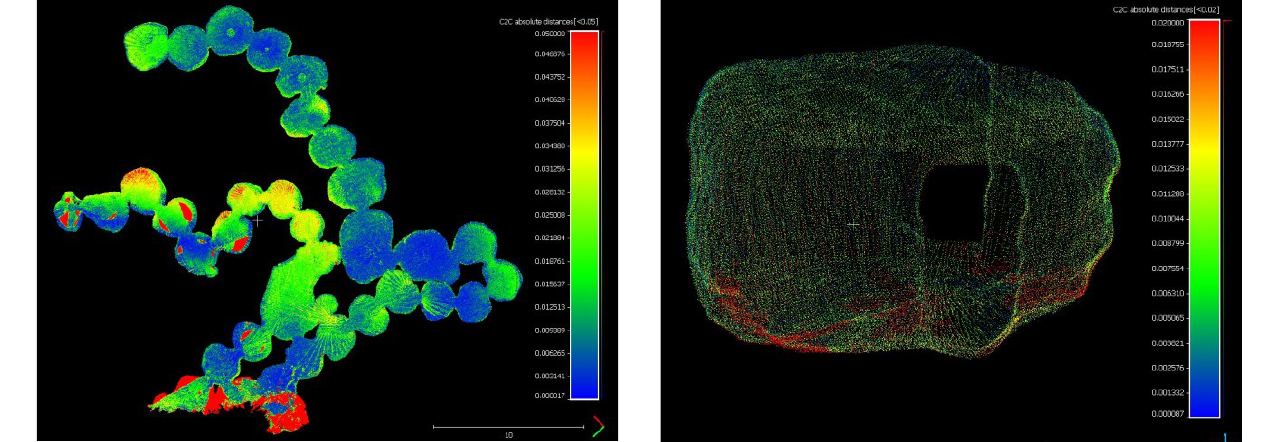
Figure 7 . C2C analyses P30-BLK2GO point clouds (calculation range: 0.00-0.02 m).